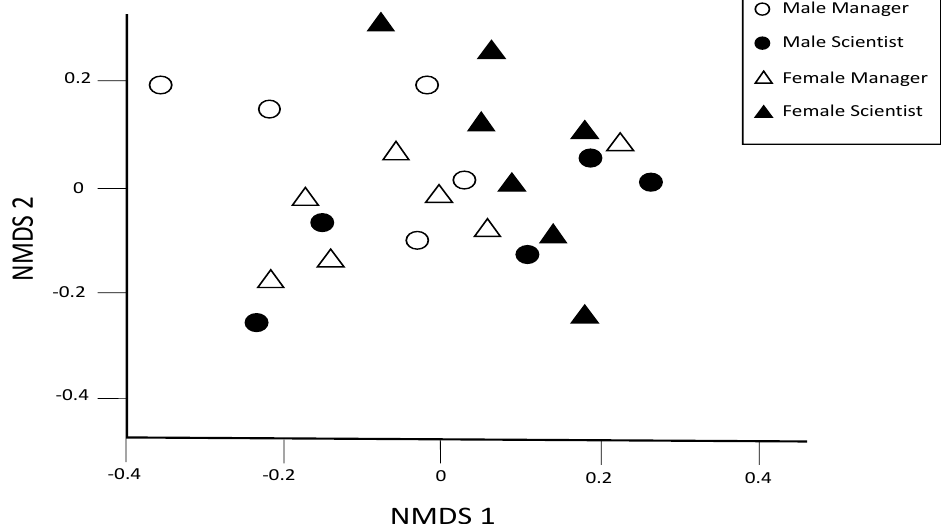
Figure 2. A plot of non-metric multidimensional scaling of individual fuzzy cognitive map-based network analysis. Each point represents a single expert and is derived from the eight metrics of model structure which we calculated from the fuzzy cognitive maps created by experts. Distance: Bray-Curtis; dimensions: 2 (2-dimensional plot represents the data structure well); stress: 0.14 (a stress level <0.2 is good); weak ties, 2 convergent solutions found after 20 tries.